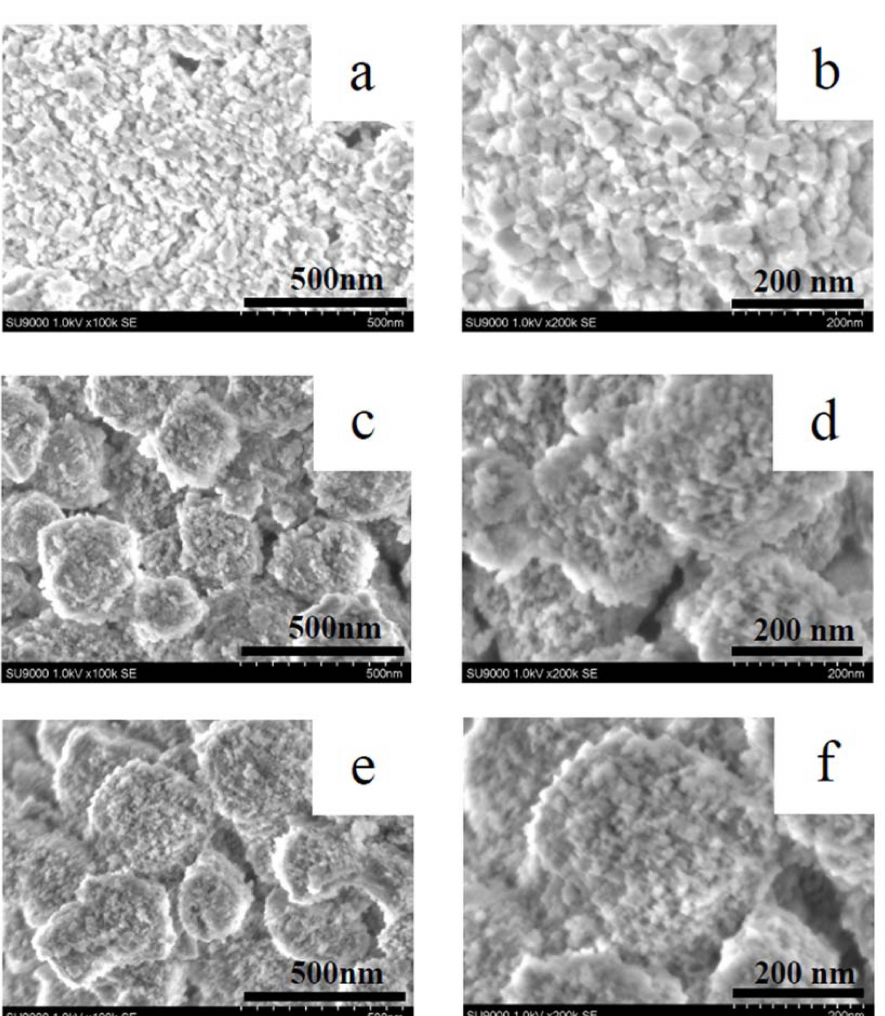
Figure 2. SEM images of HB(12) ( a , b ); HB(77) ( c , d ); and HB(77)-NT(2 M, 16 h) ( e , f ) catalysts.